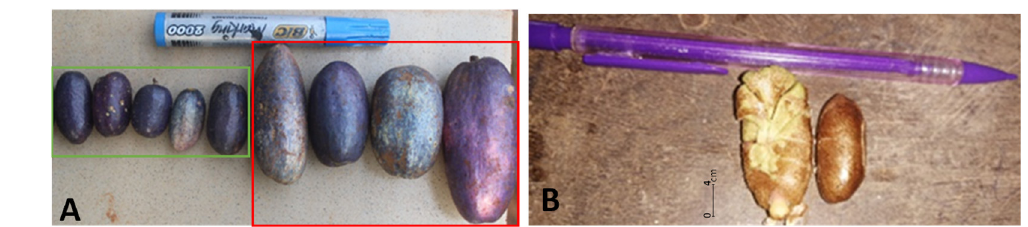
Mean and ± standard deviations measurements of fruits and seeds. For the same columns, different letters represent a significant difference at the 5% risk level.